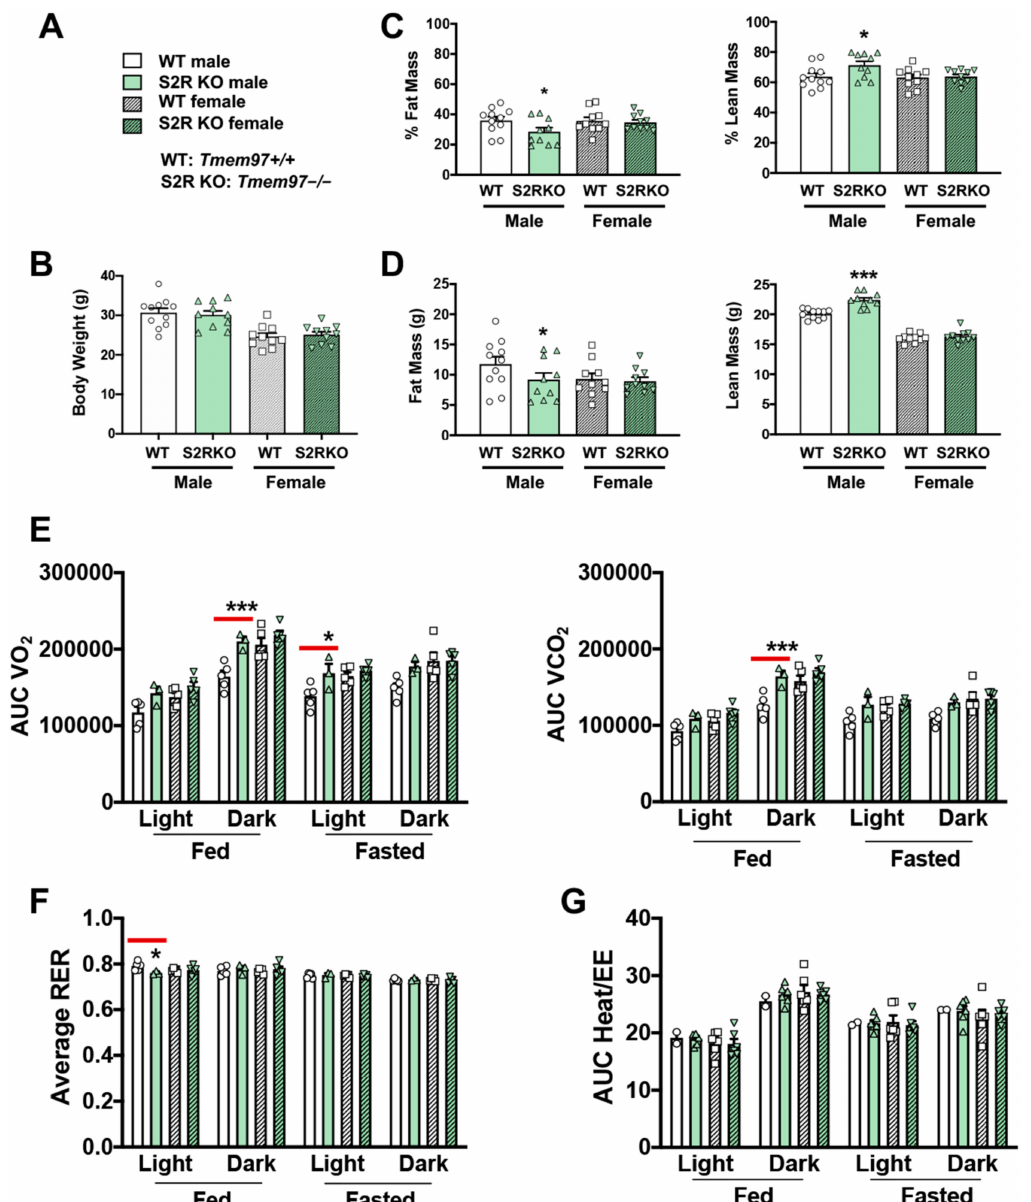
Figure 2. S2R ablation reduces fat mass and increases lean mass in male, but not female, mice fed on HFD. All measurements were performed after 6 weeks of HFD. ( A ). Legends for ( B – G ). S2R WT: Tmem97+/+. S2R KO: Tmem97 − / − . ( B ). Body weight. ( C ). Body composition (% mass vs. total mass). ( D ). Body composition (mass in grams). ( E ). Metabolism. Data were normalized to body weight. ( F ). Respiratory exchange ratio (RER). ( G ). Heat/EE. Data were normalized to body weight. Each dot (data point, please see the circle, triangle, and square symbols) on the plots represents the area under the curve (AUC) or average (for RER) of each 12-h time period for each individual animal. Statistical analysis: One-way ( B – D ) or two-way ( E – G ) ANOVA with Bonferroni’s multiple comparisons test (* p < 0.05, *** p < 0.001), S2R KO vs. WT (the comparison indicated by a red line), n = 10 or 11 mice